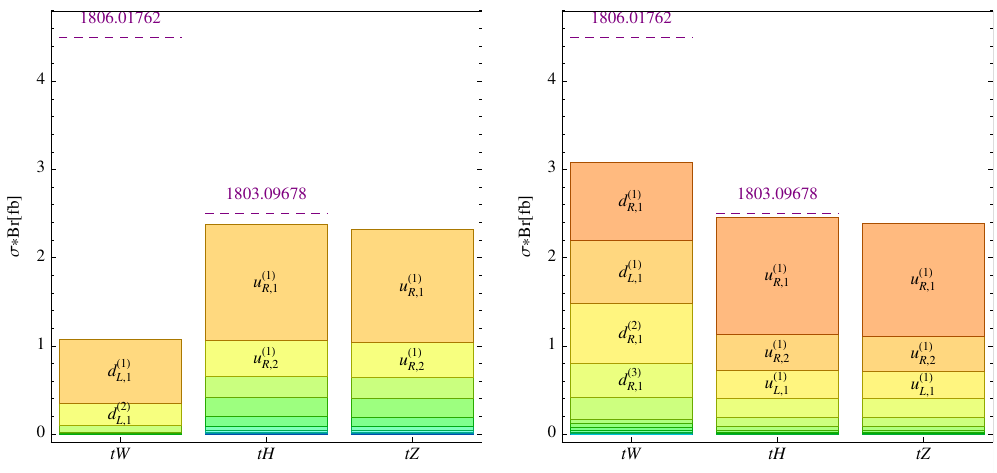
Figure 16 . The total gear pair production cross-sections in the (cid:12)nal states tW + X , tH + X and tZ + X for benchmarks 1 (left plot) and 2 (right plot). The contributions of individual gears are shown stacked and ordered top down by their increasing mass (decreasing cross-section). The currently most stringent upper bounds, obtained by recasting of searches for vector-like quarks in the tW + X [115] and tH + X (the 1-lepton channel) [116] (cid:12)nal states, are denoted with dashed lines. The corresponding bound on the tZ + X [116] (cid:12)nal state is much weaker and is not shown (it is outside the (cid:12)gure